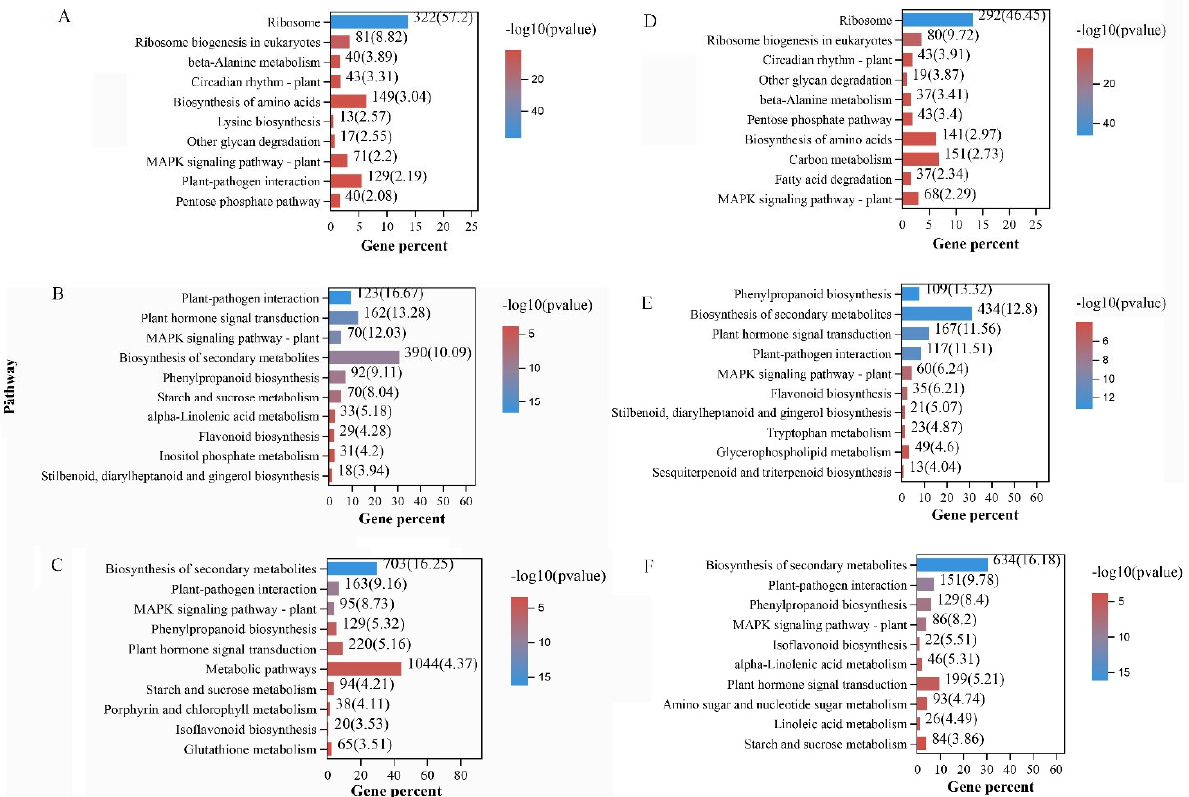
Figure 4. Kyoto Encyclopedia of Genes and Genomes (KEGG) enrichment analysis of DEGs identified. ( A ) KEGG analysis of DEGs between 6 hpi vs. 0 hpi in susceptible variety. ( B ) KEGG analysis of DEGs between 48 hpi vs. 0 hpi in susceptible variety. ( C ) KEGG analysis of DEGs between 5 dpi vs. 0 hpi in susceptible variety. ( D ) KEGG analysis of DEGs between 6 hpi vs. 0 hpi in resistant variety. ( E ) KEGG analysis of DEGs between 48 hpi vs. 0 hpi in resistant variety. ( F ) KEGG analysis of DEGs between 5 dpi vs. 0 hpi in resistant variety.